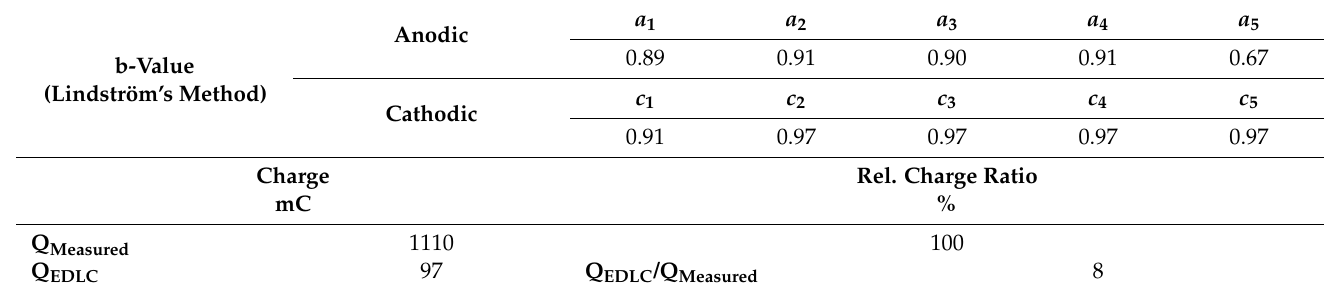
The peaks named a 1 – a 5 , as well as c 1 – c 5 in CXG 500 CVs, were randomly selected to give Table A4. Overview of results of graphite||Al experiments reported in Figure a good overview over the whole CV. Please note that the nomenclature has nothing to do